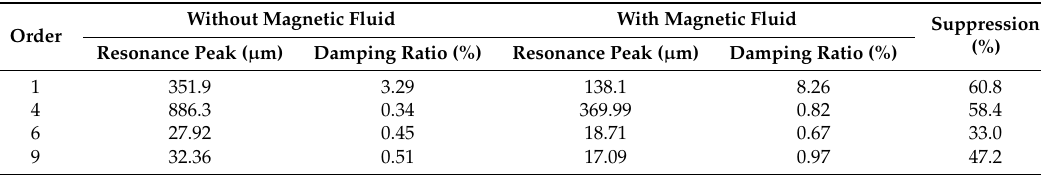
Table 2. Comparison between the predicted resonance peaks at the end of the feedback rod with and without magnetic fluids.